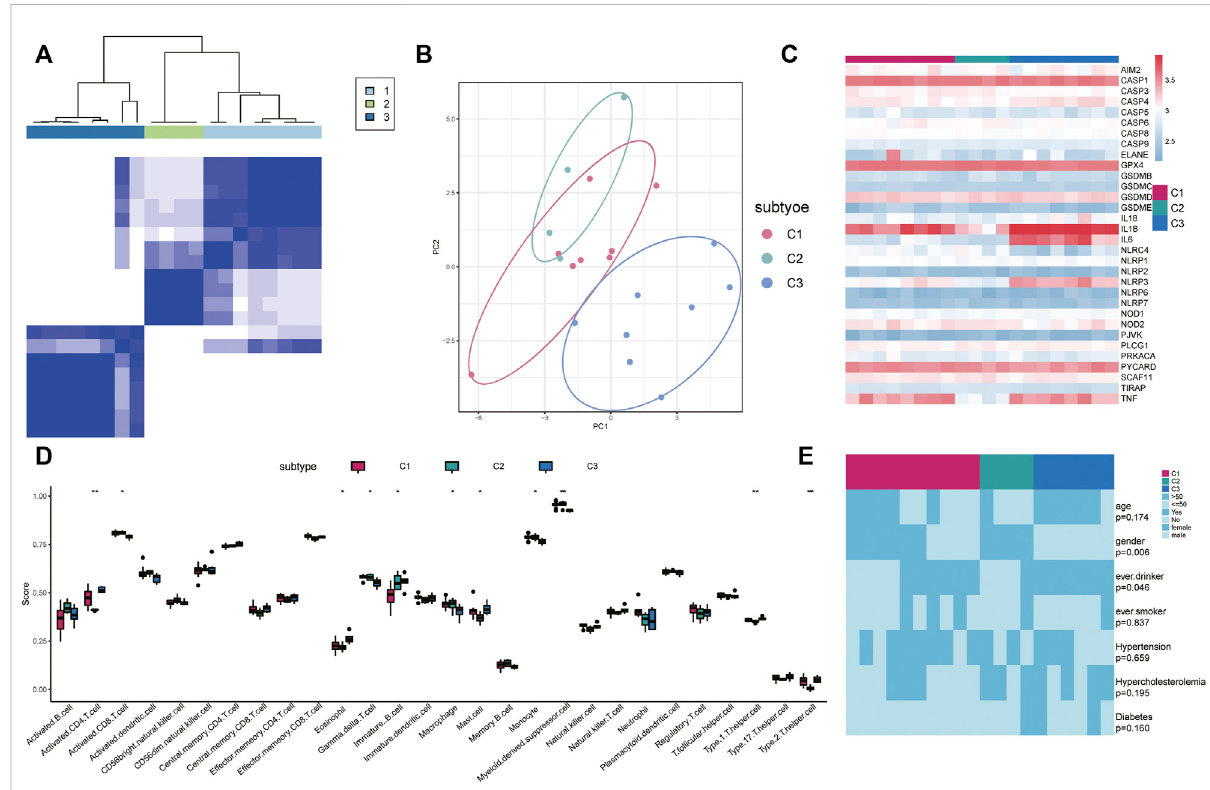
FIGURE 5 Identi fi cation of different pyroptosis expression patterns. (A) Heatmap of the matrix of co-occurrence proportions for IS samples. Blue: low- expression level; red: high-expression level. (B) Principal component analysis for the transcriptome pro fi les of three pyroptosis subtypes, showing a remarkable difference in the transcriptome between different modi fi cation patterns. (C) Expression status of 33 PRGs in the three pyroptosis subtypes. (D) Unsupervised clustering of 33 PRGs in the three patterns (E) Comparison of age, sex, smoking, alcohol